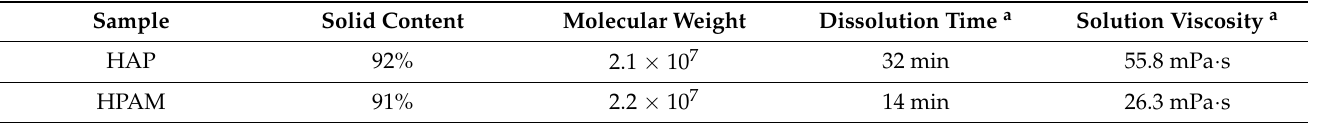
Table 2. The property comparison of HAP and